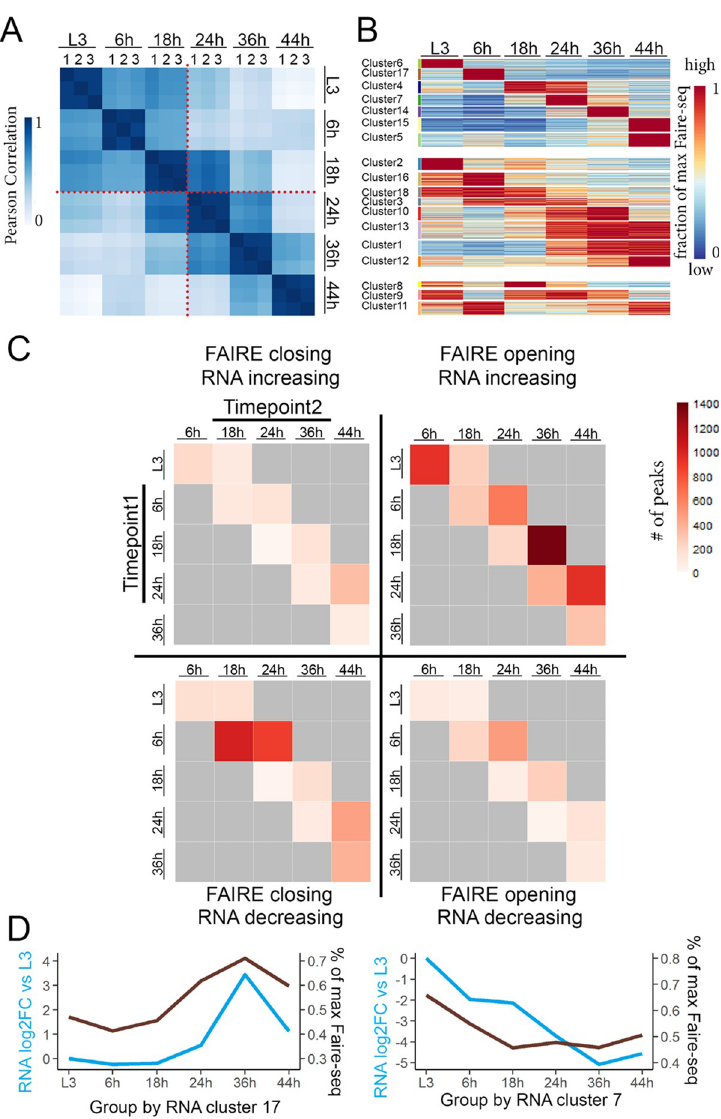
Fig 1. Dynamics of chromatin accessibility and gene expression are correlated during metamorphosis. (A) Open chromatin regions (peaks) in wings were identified by FAIRE-seq on time points prior to metamorphosis (L3) and during pupal stages 6 h, 18 h, 24 h, 36 h, and 44 h APF. Heatmaps of Pearson correlation coefficients for each replicate across this time course reveal differences between the proliferative and postmitotic stages (red dotted line). (B) Dynamic open chromatin peaks were organized into 18 k-means clusters, displayed as a heatmap representing the fraction of the maximum FAIRE rpkm value. (C, D) Most chromatin accessibility changes are associated with gene activation rather than repression during metamorphosis. (C) We assigned dynamic FAIRE peaks to the nearest expressed gene and correlated peak changes (opening or closing) with observed gene expression changes (increasing or decreasing) measured by RNA-seq at each subsequent time point. This revealed four classes of FAIRE peak/RNA expression correlations: opening/increasing consistent with gene activation, closing/decreasing consistent with loss of activation, opening/decreasing consistent with binding of a repressor, and closing/activation consistent with a loss of repression. We show the number of dynamic FAIRE peaks that fall into each quadrant for comparisons at time point 1 (t1) (y-axis) and time point 2 (t2) (x-axis). (D) Genes were clustered based on RNA expression patterns across metamorphosis. Two clusters showing a high positive correlation between RNA signal (average log2 fold change from L3) and accessibility of their assigned FAIRE peaks (average maximum FAIRE rpkm value) are shown. The full dataset correlating RNA expression with accessibility of their assigned FAIRE peaks for all clusters is provided in the Supporting information. The underlying data in Fig 1A–1D can be found within S1 Data. APF, after puparium formation; Cdk, cyclin-dependent kinase; FAIRE, formaldehyde-assisted isolation of regulatory elements; FAIRE-seq, FAIRE sequencing; RNA-seq, RNA sequencing; rpkm, reads per kilobase, per million mapped reads.